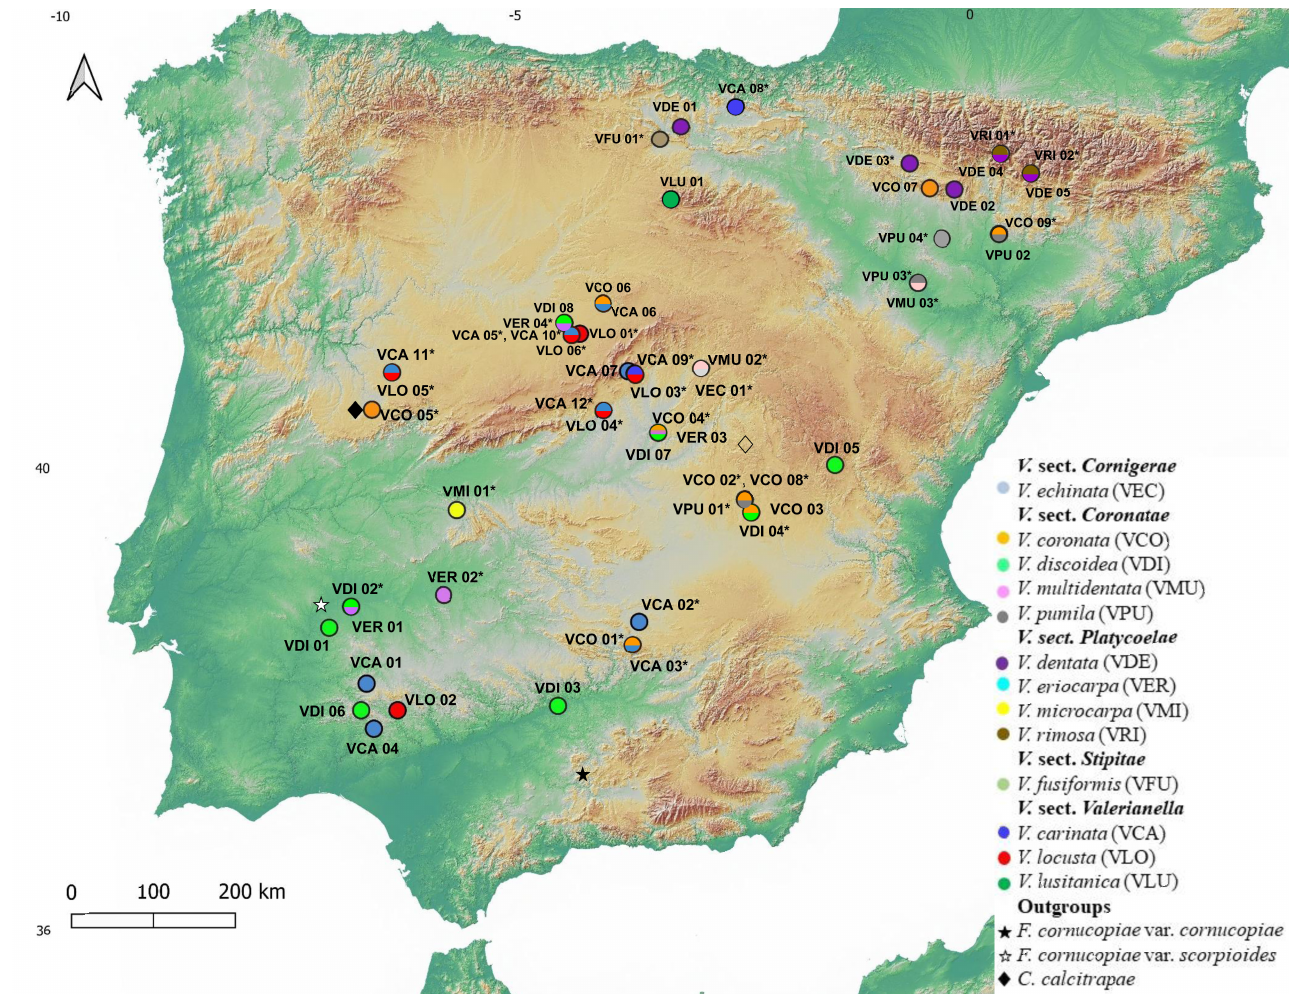
Figure 1. Geographical distributions of the studied populations of the Valerianella species, Fedia cornucopiae var. cornucopiae (white star) and var. scorpioides (black star) and Centranthus calcitrapae (diamonds) in the Iberian Peninsula. Color codes of Valerianella species are indicated in the